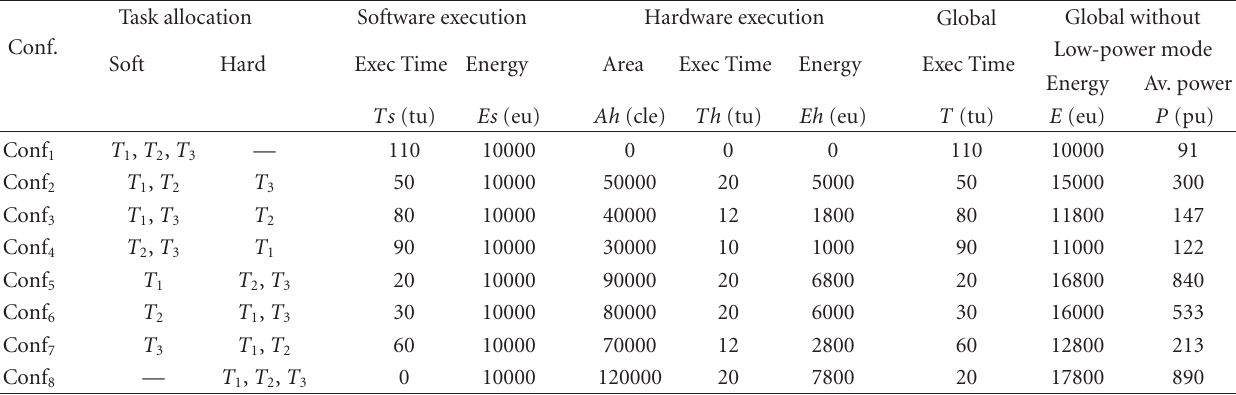
Table 2: Example of possible combinations of task allocations within the execution platform when considering that the processor is always active even if no software task have to be executed. Note that the first and last rows are those which are not acceptable due to the total task execution delays ( T > Pp ) or the total task areas ( Ah > A ). Remarks: Conf 1 is incorrect due to the total execution time greater than the period of tasks; Conf 8 is incorrect due to the total area greater than the global area in the reconfigurable space. Conf.